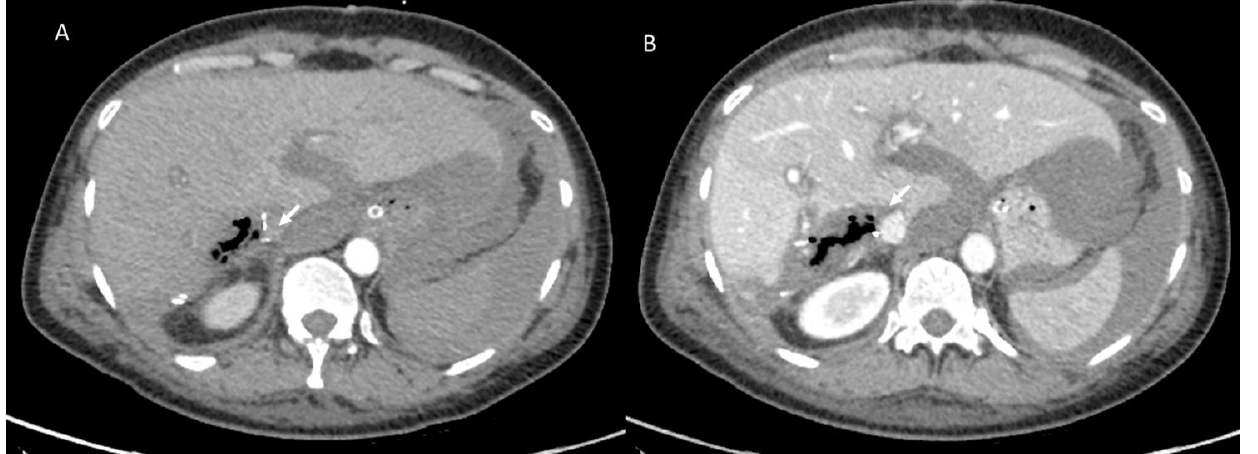
Figure 3. Hepatic abscess in resected hepatocellular carcinoma on VI hepatic segment, evaluated with CT. Arrow shows air artifacts within the collection in arterial ( A ) and portal ( B ) phase of con- trast study.